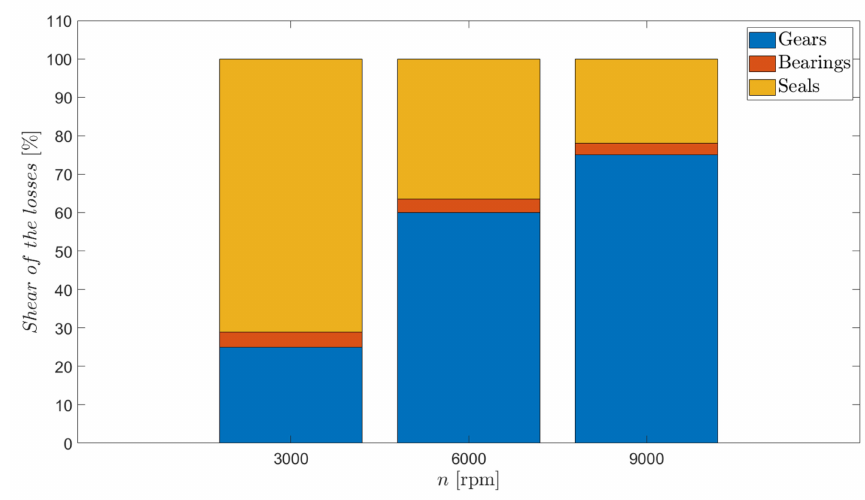
Figure 9. Percentage share of the different components for the no-load losses.